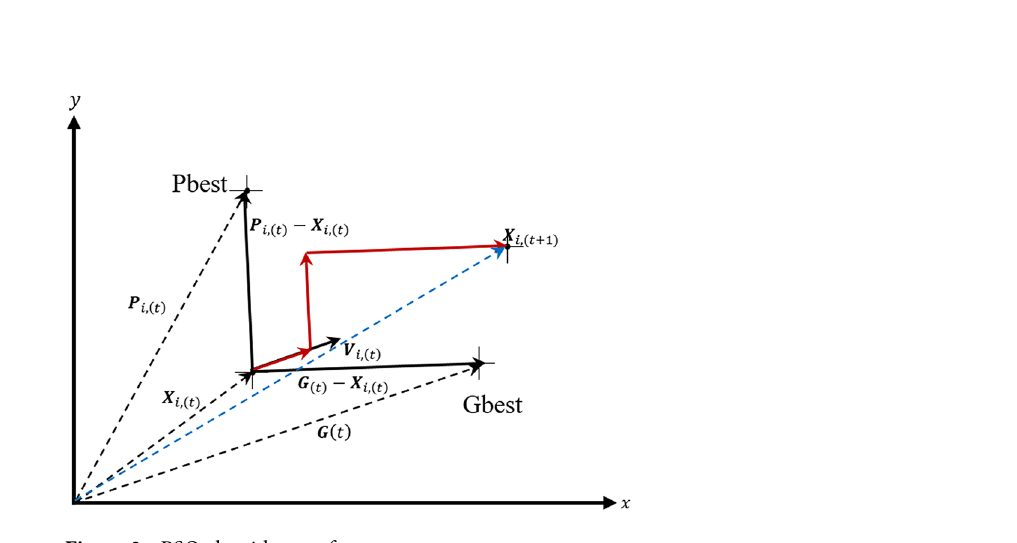
Figure 3. PSO algorithm performance.